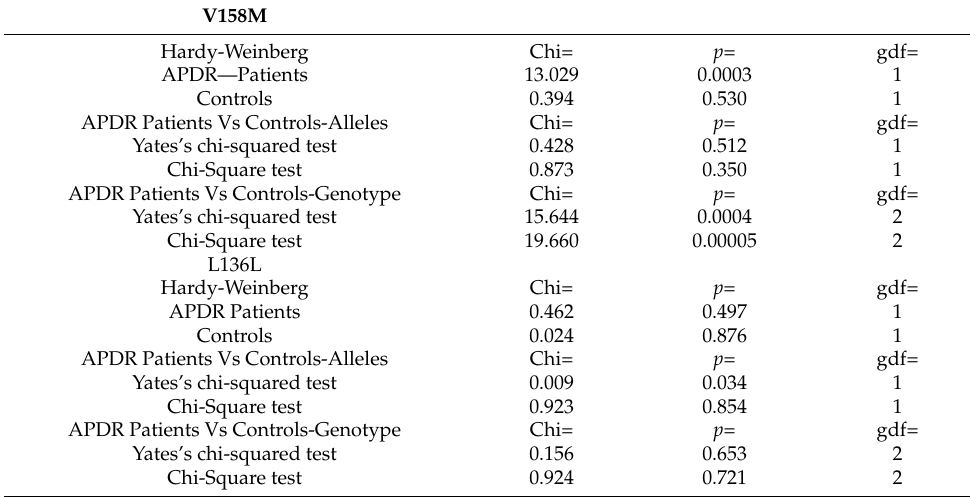
Table 4. Chi-square test results for Hardy-Weinberg equilibrium of gene frequency and alle- les/genotypes discordance between APDR patients and control